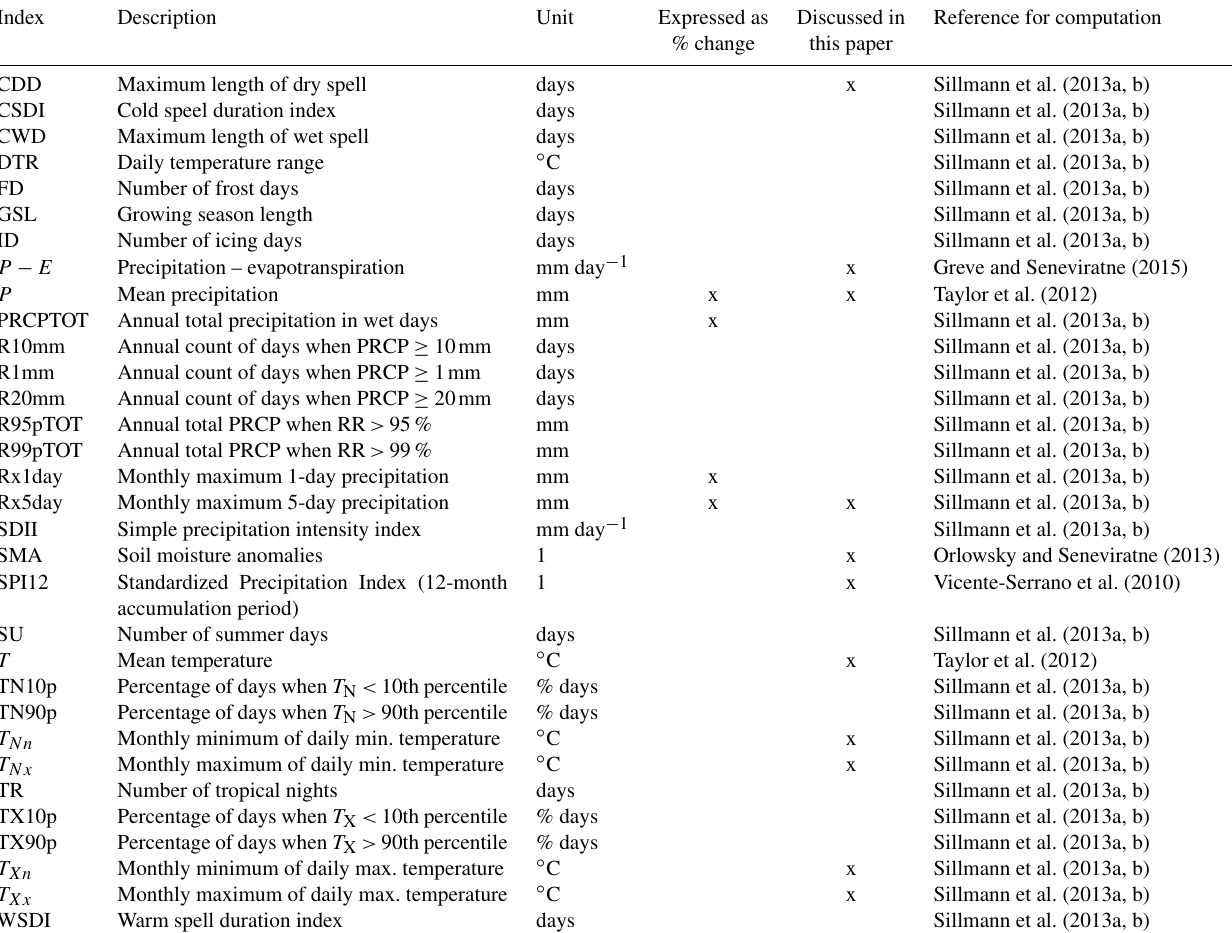
Table 2. List of indices (in alphabetical order) as presented in the DROUGHT-HEAT Regional Climate Atlas. Crosses denote indices specifically discussed in this paper as well as indices expressed as percent changes relative to the pre-industrial reference period (1861–